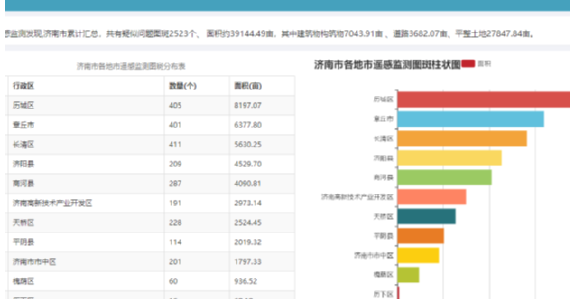
Figure 8. Analysis briefings function interface